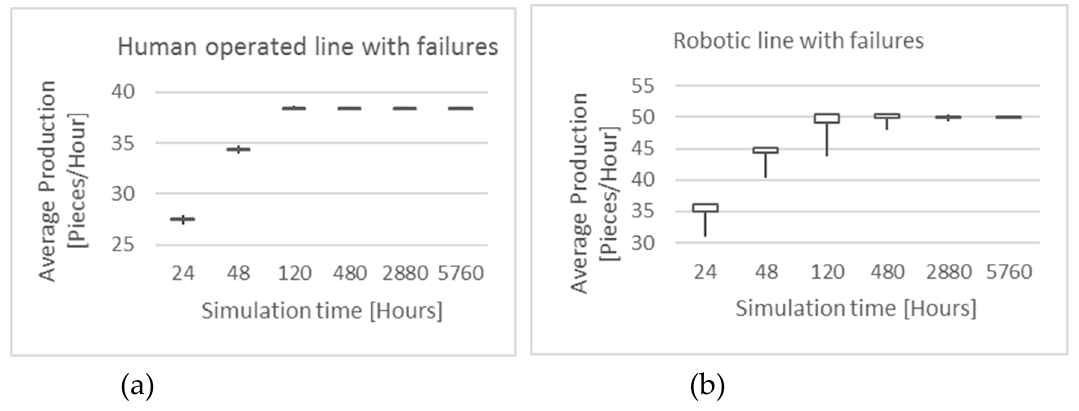
Figure 7 . The trend of average production value [pieces/hour] for a ) manually operated line with Figure 7. The trend of average production value [pieces / hour] for ( a ) manually operated line with failures , b ) robotic line with failures (20 samples, confidence level 90%) failures, ( b ) robotic line with failures (20 samples, confidence level